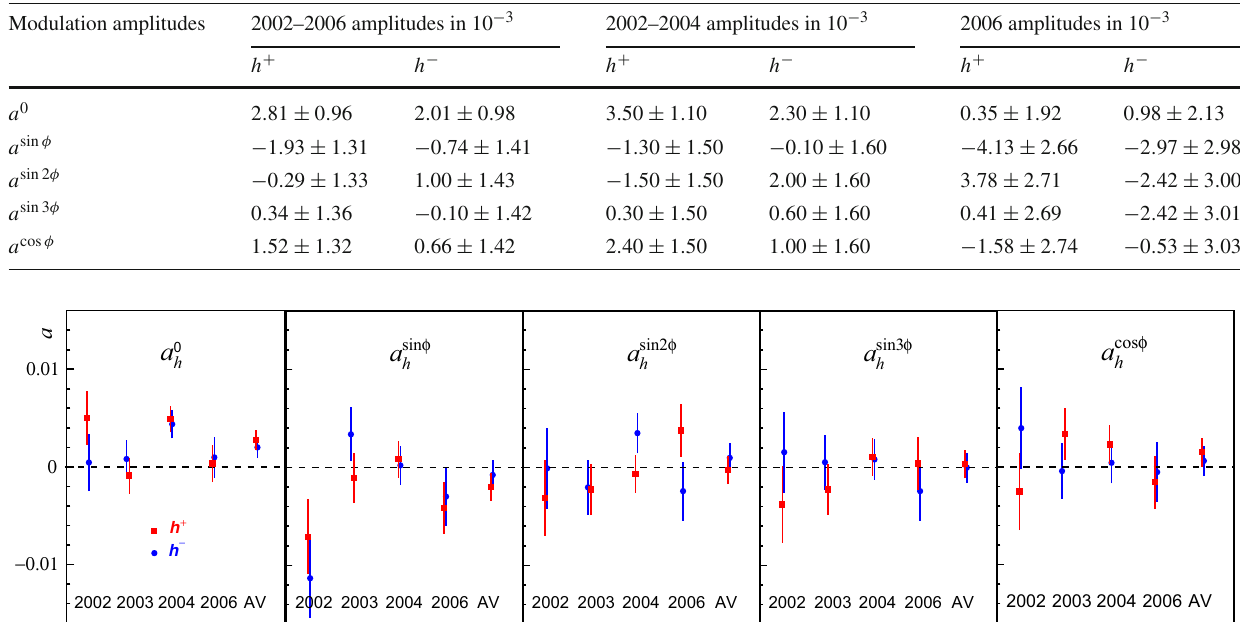
Fig. 5 The values of modulation amplitudes a together with their uncertainties obtained from the fits of the integrated asymmetries a h ± (φ) by the function from Eq. (4) separately for the data of 2002,